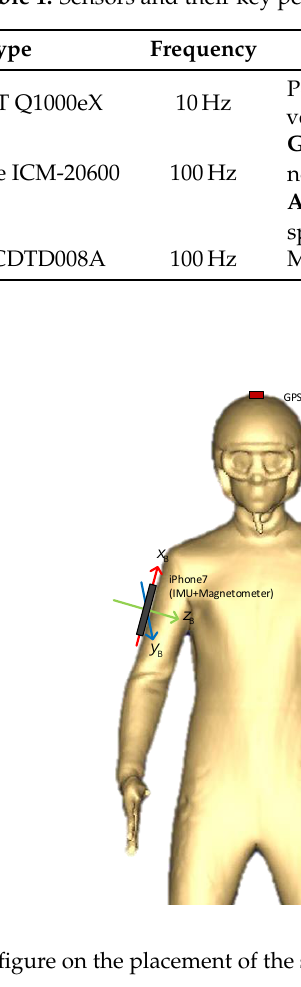
Table 1. Sensors and their key performance information.